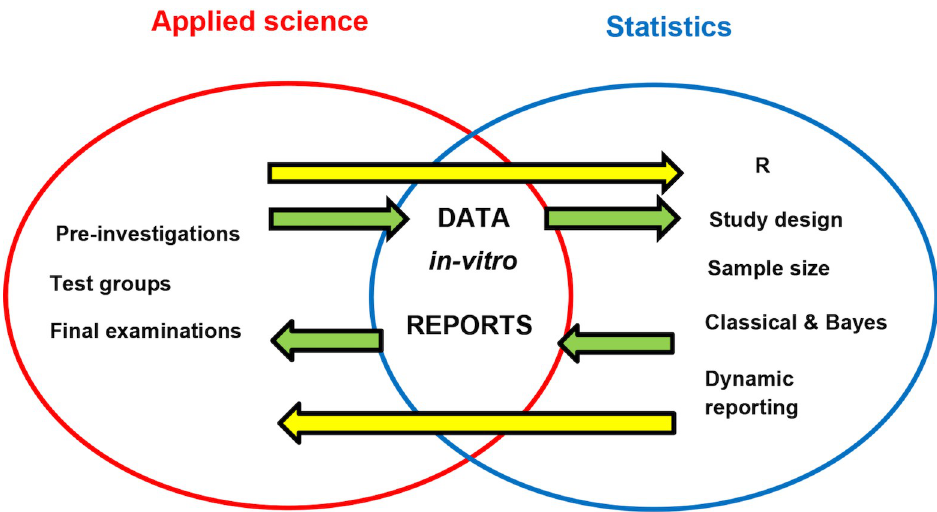
Fig 1. Project with two equal partners from an applied science on the left and statistics on the right. Within this project, both partners must accomplish the tasks listed. Both partners communicate either directly (yellow arrows) or indirectly (green arrows) through provisional results including in vitro raw data and statistical